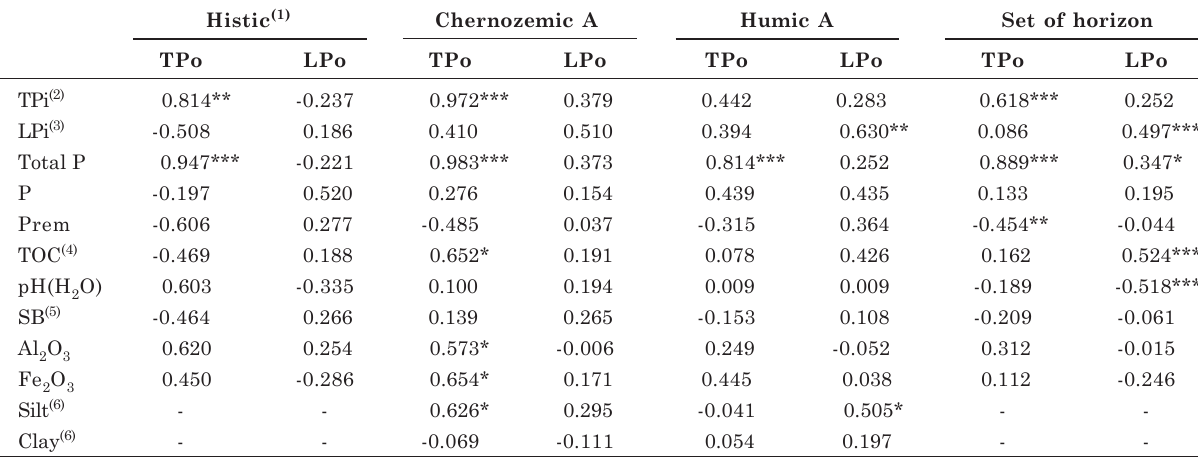
Table 5. Coefficient of correlation between total organic P (TPo) and labile organic P (LPo) with chemical properties and particle size distribution in the surface horizons of different soil